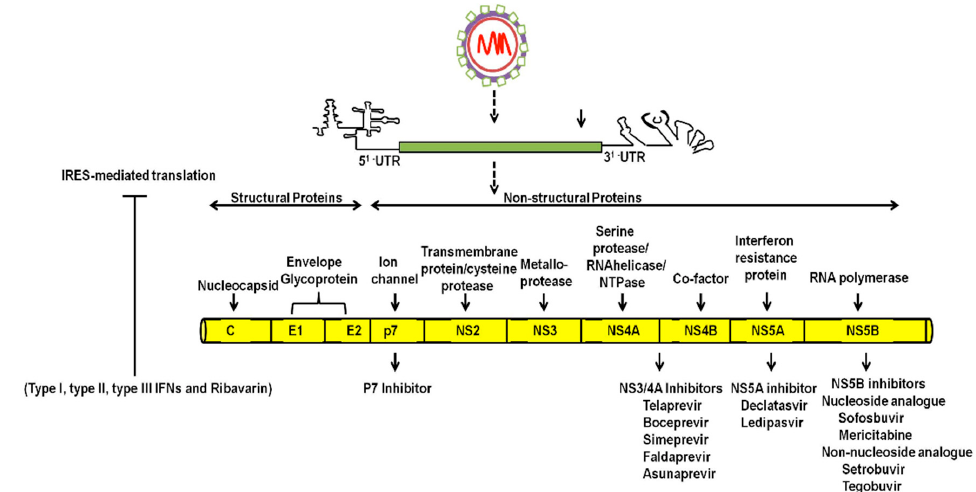
Figure 1. Structure of hepatitis C virus (HCV) RNA genome and ten different mature proteins are produced from the single large open reading frame (ORF). Type I, Type II, and Type III interferons, and ribavirin specifically inhibit the internal ribosome entry site (IRES, 5’UTR) function. Core, E1 and E2 are structural proteins and NS2–NS5 are non-structural proteins. The non-structural proteins (NS3/4A, NS5A and NS5B) are the targets of antiviral drug discovery. The 3’-UTR is important for HCV genome replication.